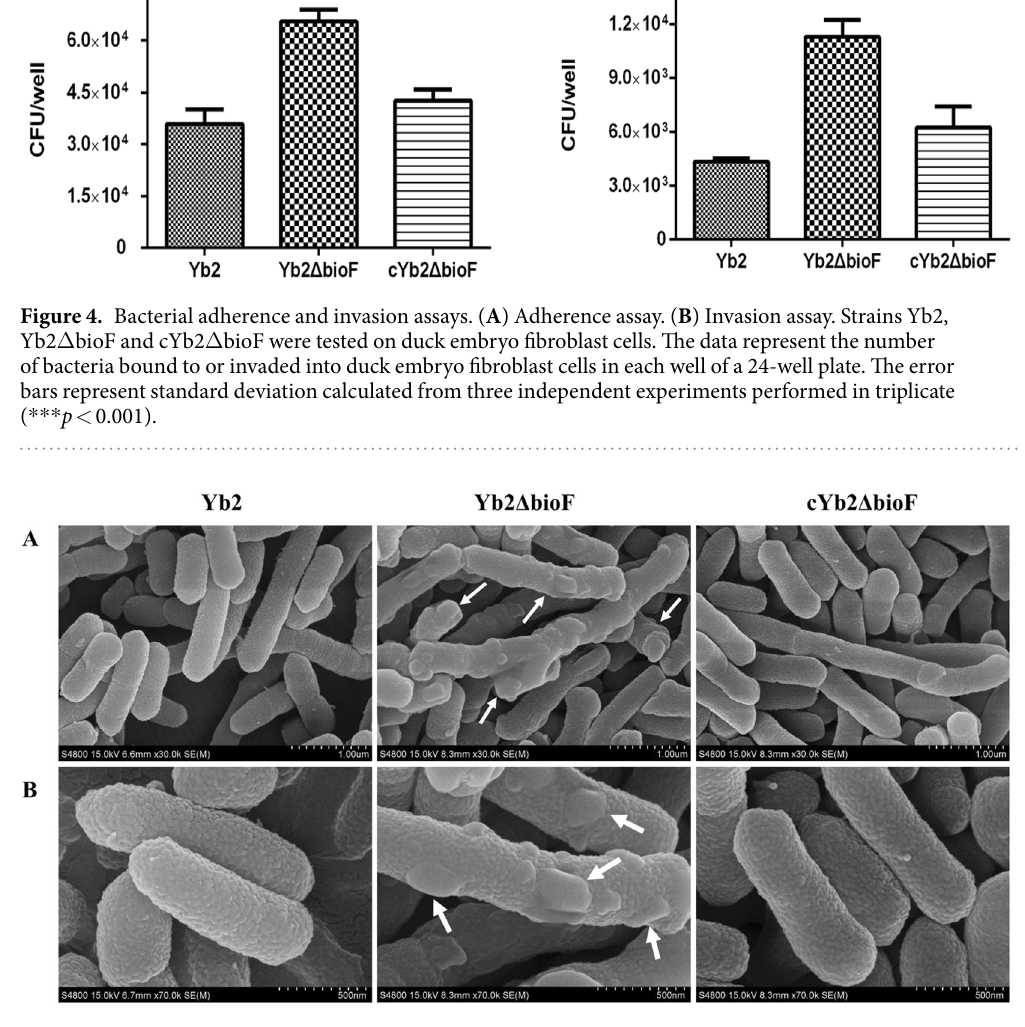
Figure 5. Morphological observation. ( A ) Low magnification; ( B ) high magnification. The shapes and sizes of wild-type strain Yb2, mutant strain Yb2 Δ bioF and complemented strain cYb2 Δ bioF are shown. The images were captured using a scanning electron microscope. Budding vegetations (white arrows) on the surface of mutant strain Yb2 Δ bioF were